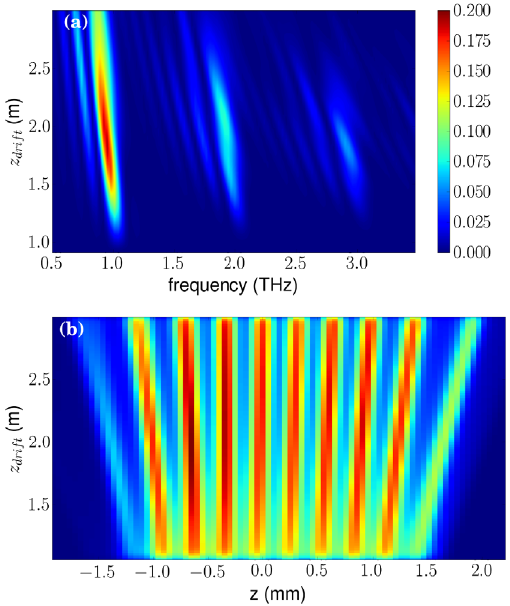
FIG. 5. Bunch form factor (BFF) (a) and bunch longitudinal density (b) evolution as a function of the drift length referenced with respect to the DLW exit. The simulations correspond to the parameters listed under the S-band column in Table I.